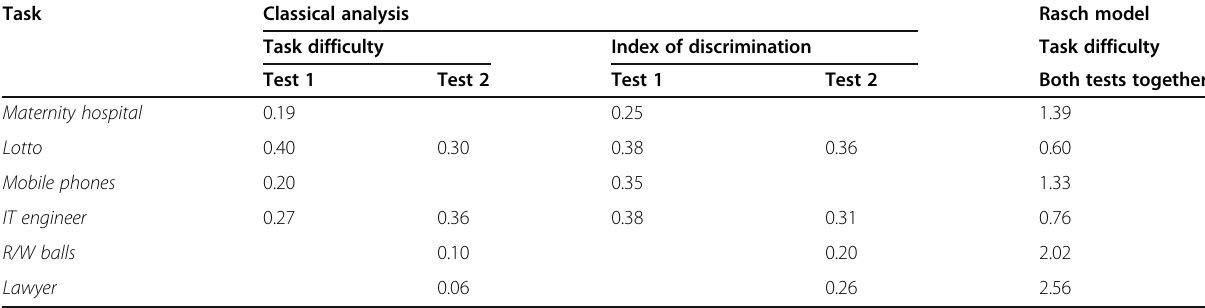
Table 3 Classical analysis and Rasch model parameters for both tests